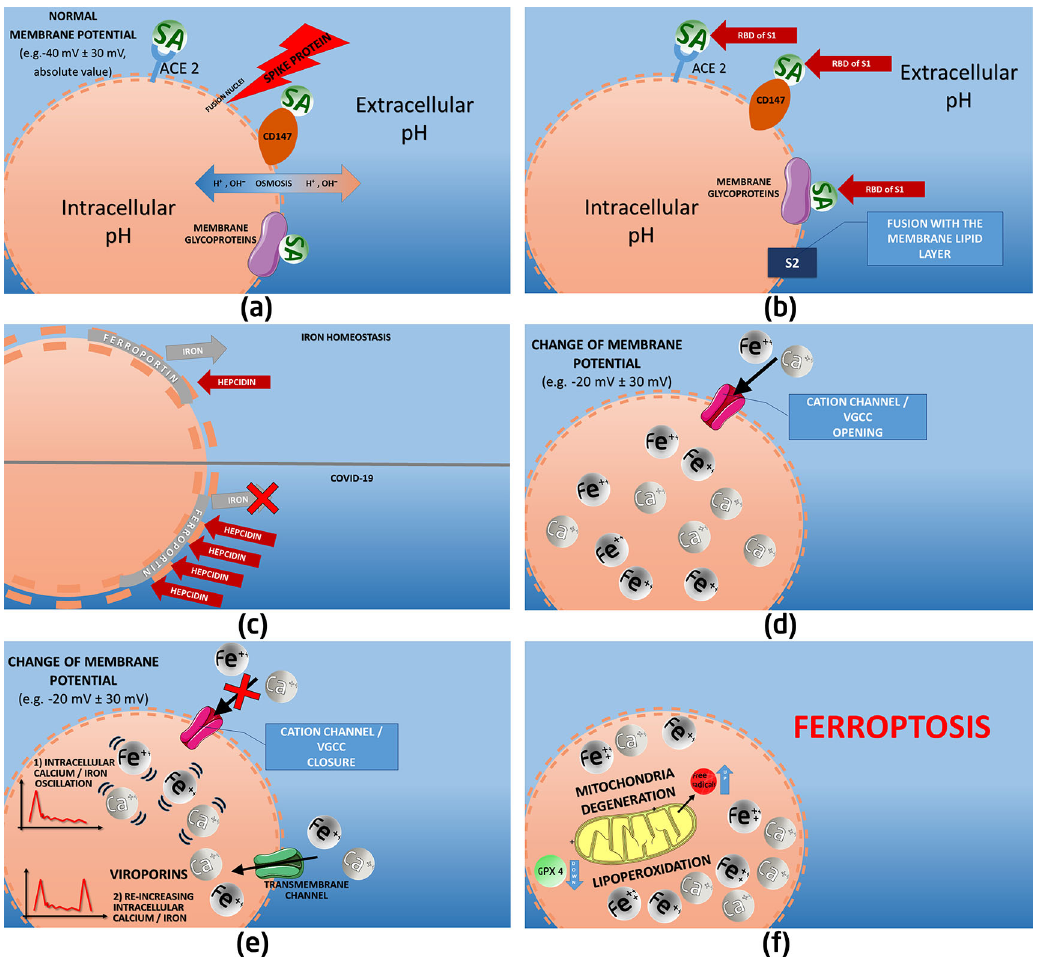
Figure 1. a) Docking approach of the spike protein with the host cell membrane, which presents three main receptors: ACE2, CD147 and Sialic Acid (SA); SA is expressed on the membrane glycoproteins and on the outer site of the other two receptors. b) The two subunits of the spike protein (S1 and S2), derived from priming and cleavage by hydrolases (TMPRSS2) and furins, contact host cell membrane: S1 receptor binding domain (RBD) attach ACE2 and CD147 through SA and directly SA on the membrane glycoproteins; S2 enters the lipid layer of the cell membrane. c) Upper part: normal hepcidin-ferroportin axis; lower part: COVID-19 situation, with hyper-concentrated plasma hepcidin molecules that bind the extracellular portion of the transmembrane ferroportin, thus blocking iron extracellular transport and favoring intracellular ferritin accumulation. d)Decrease ofthemembranepotential(lessnegativelycharged),whichisalteredbytheformationofseveral dipoles between SA negative and S1 positive; consequent opening of the cation channels, especially of the voltage gated calcium channels (VGCC), with intracellular entry of cations, primarily calcium and iron. e) Cell homeostasis,aftercationentry,rapidlybringsclosureofVGCCandcationchannels(1intracellularoscillation with one peak of cations); simultaneous viroporin action of membrane channeling which brings opening of new channels and re-entry of cations (2 intracellular oscillation with a second peak of cations). f) Ferroptosis: excessive cation concentration, increase of free radicals, depletion of glutathione peroxidase 4 (GPX4), lipoperoxidation of membranes and organelles, mitochondria